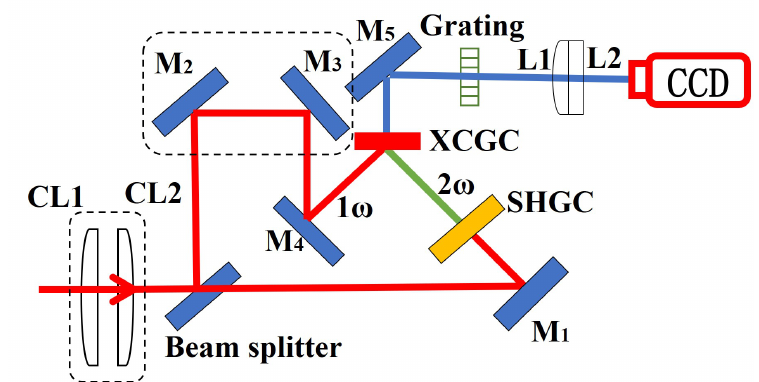
Figure 5. Schematic of homemade ps − THG − FROG used for